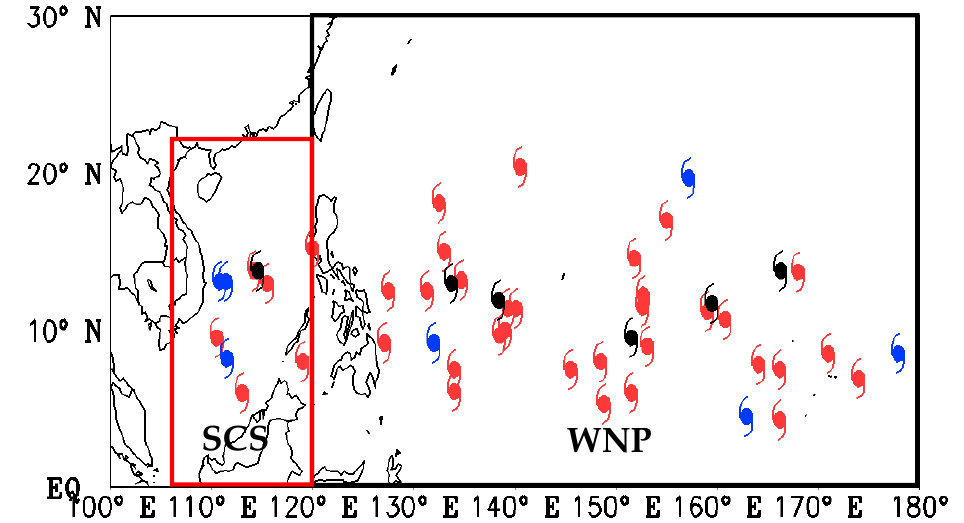
Figure 2. The genesis locations of TCs in November in the year 2019 (black), the years with high TC frequency (red), and the years with low TC frequency (blue), with different geographic locations for the WNP basin (equator to 30° N, 120° to 180° E) and the SCS (equator to 22° N, 105° to 120° E).